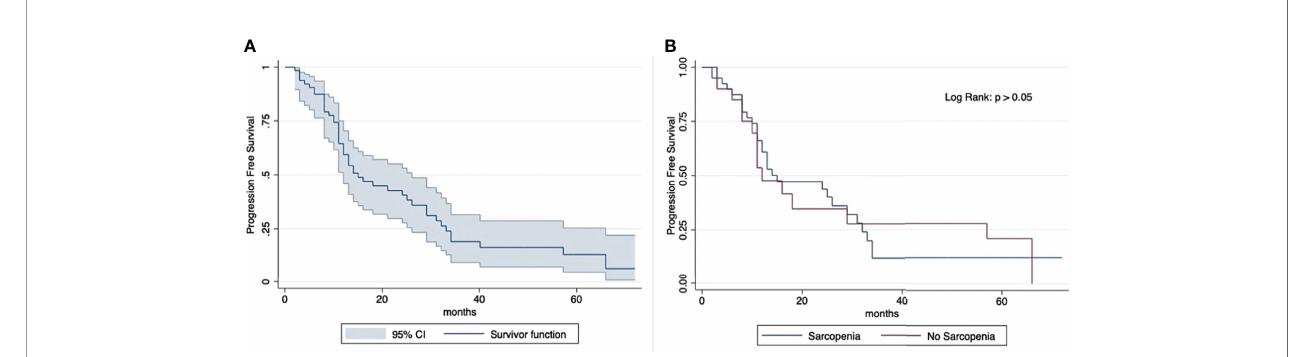
FIGURE 3 | Kaplan-Meier curve showing progression-free survival for total sample (A) and by sarcopenia (B) . Median OS: 13 months (IQR: 17 months). 2-year PFS rate: 41% (sarcopenic: 35%; non-sarcopenic: 44%); 5-year PFS rate: 13% (sarcopenic: 21%; non-sarcopenic: 12%). The progression-free survival shows an overlap in the two groups divided according to sarcopenia.